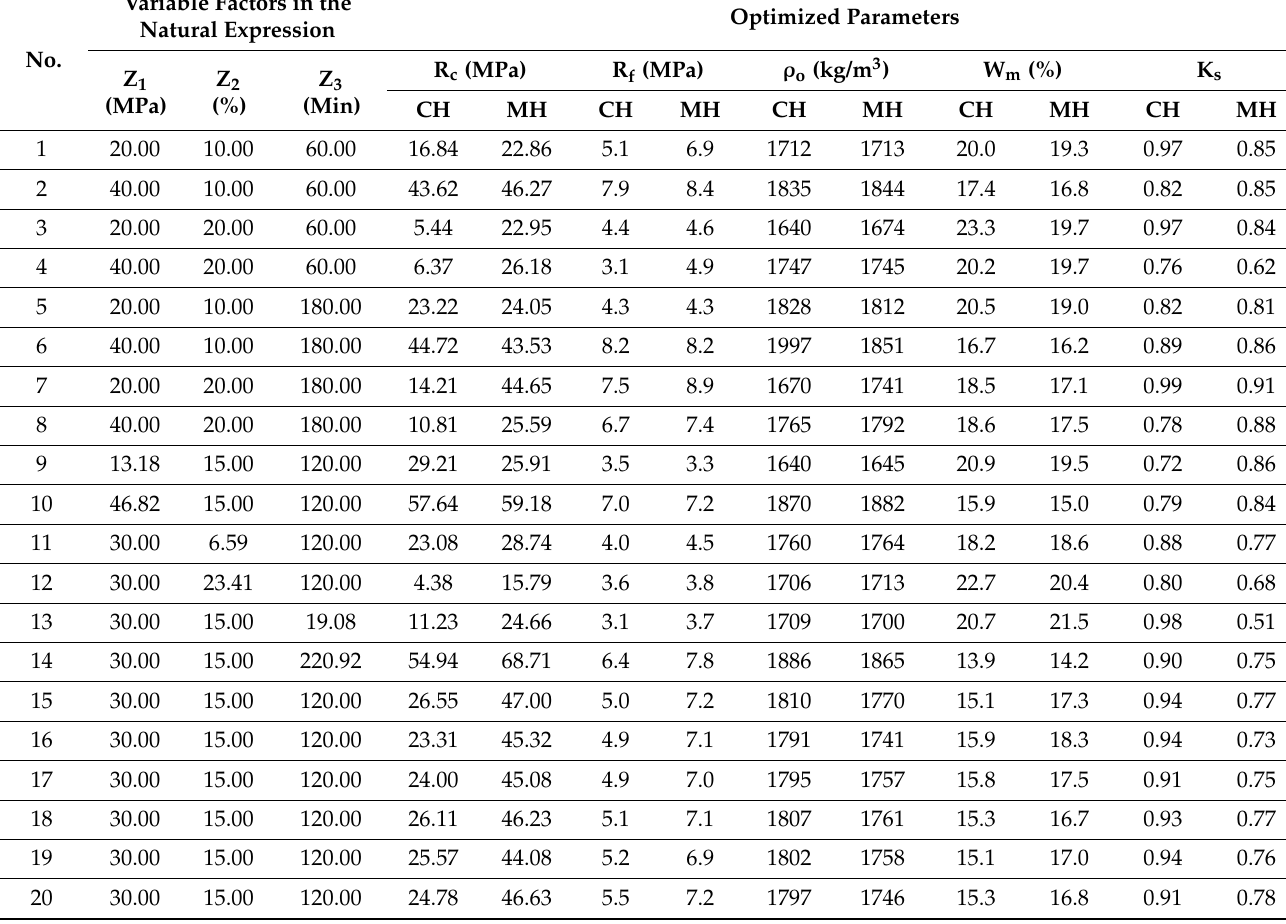
Table 5. Experimental data of the properties of the experimental samples were obtained immediately after the carbonisation (CH) and after a subsequent 28 days of hardening (MH).